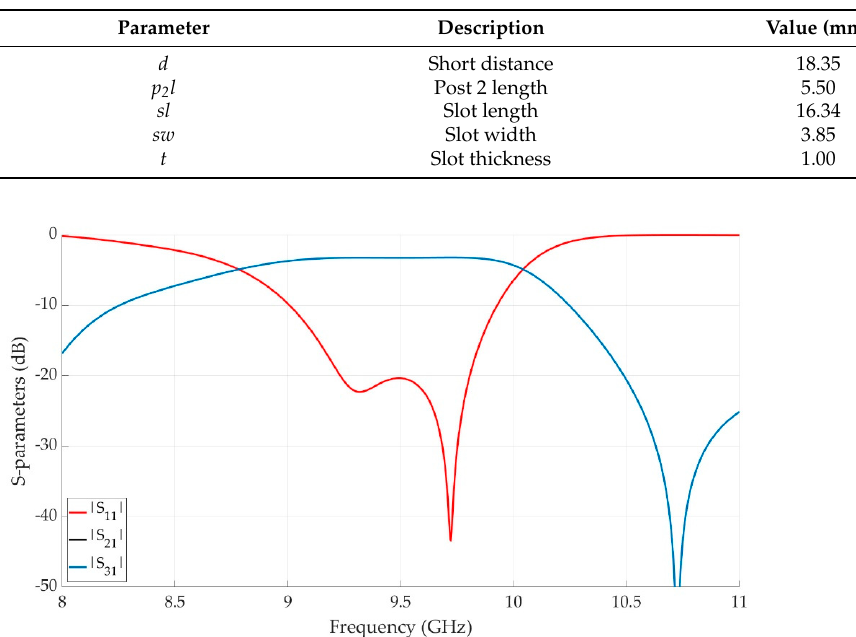
Figure 7. E-plane T-junction geometry. ( a ) Top view. ( b ) 3D view. Table 3. E-plane T-junction geometrical parameters.